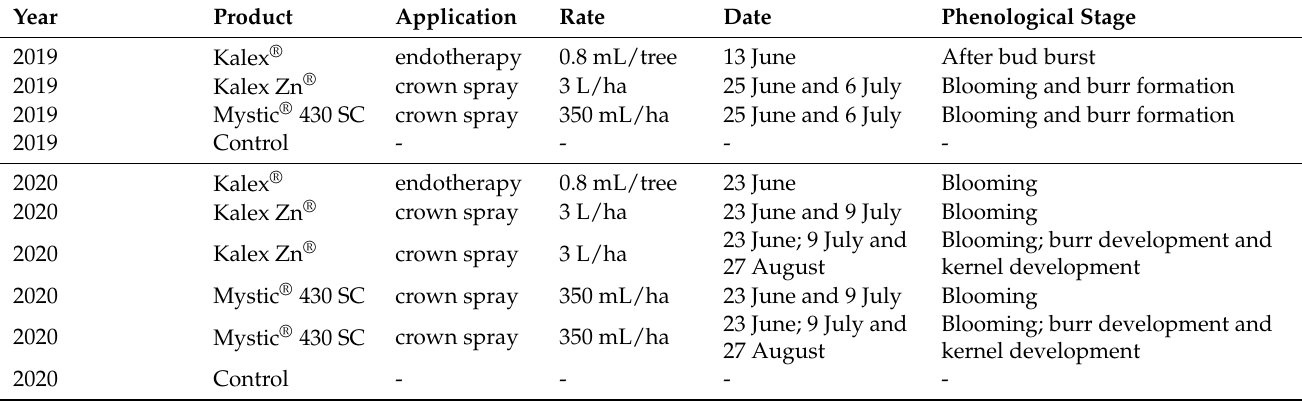
Table 1. Details of treatments, rate, application date, and phenological stage for field trials conducted at the chestnut